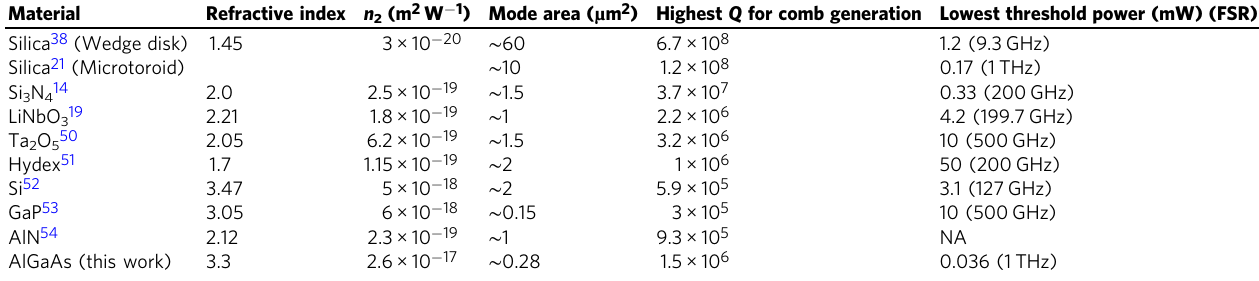
Table 1 Performances of various nonlinear materials for microcomb generation. Material